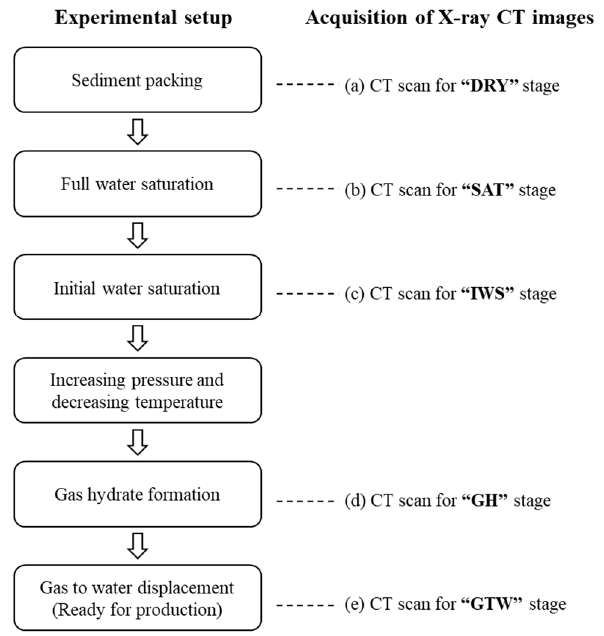
Figure 2. Flow chart of the gas hydrate (GH) generation experiment with computerized tomography (CT) scanning for obtaining the machine-learning data. ( a ) A sand sample made in DRY stage; ( b ) water saturated sample in SAT stage; ( c ) gas and water saturated status in IWS stage; ( d ) GH generation by pressurization in GH stage; ( e ) water replaces gas in GTW stage.